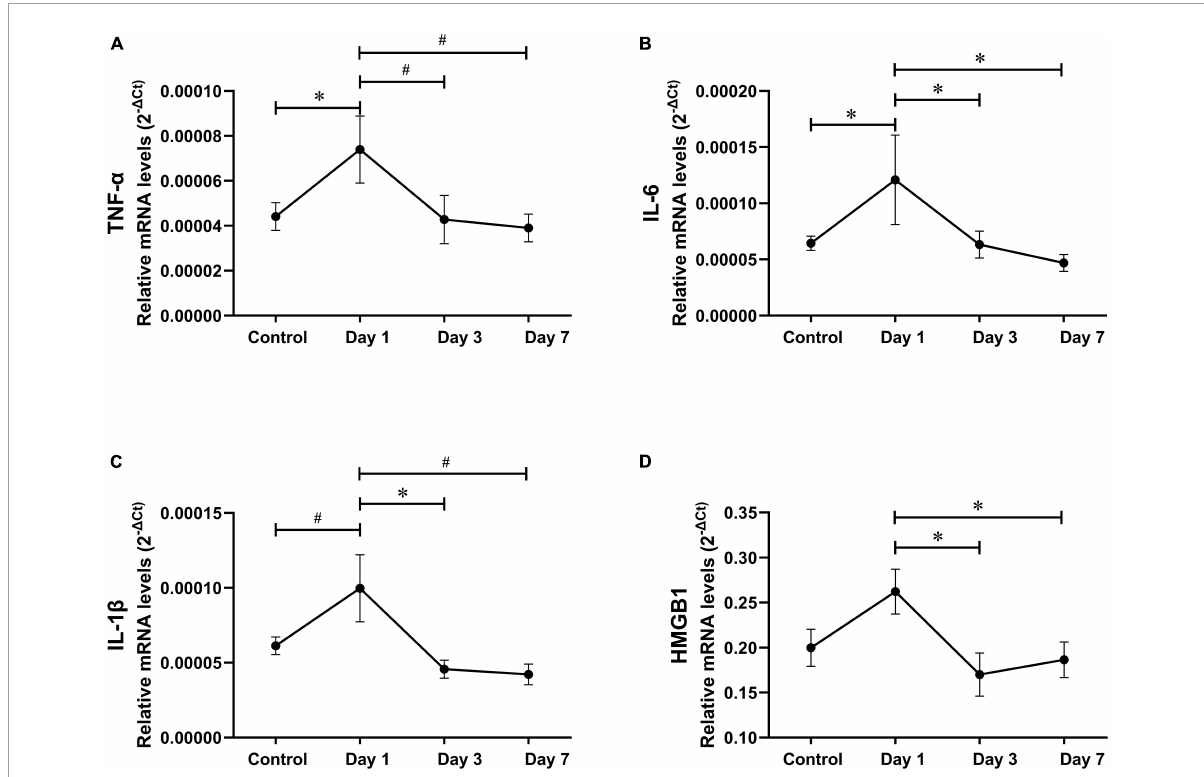
FIGURE7 Hippocampal inflammatory trend after extended abdominal surgery. (A–D) TNF- α , IL-6, IL-1 β , and HMGB-1 mRNA levels on postoperative days 1, 3, and 7. Data represent mean ± SEM ( n = 9–12 per group). # P < 0.01; ∗ P < 0.05.